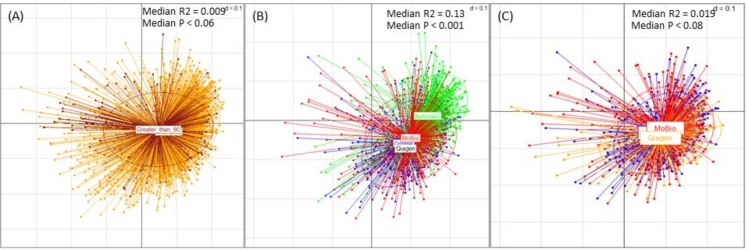
Effect of median read length and DNA extraction techniques on the microbiome variation.(A) PCoA Plot showing the relatedness of the microbiome profiles of the ExperimentHub datasets of different median read length ranges. The different read length categories (into which the datasets were grouped) were’ 30 to 90’ (base pairs) and ‘Greater than 90’ (base pairs). The R-squared value and P-value of the association obtained using bootstrapped envfit iterations (sub-sample size = 200 and number of iterations: 25) are indicated. (B) PCoA analysis of the effects of the DNA extraction methods on the microbiome profiles, indicating that the samples extracted using the method tagged as ‘Illuminakit’ (shown in Green) (used by SchirmerC_201635), had a profile significantly different from those used by other methods (‘Gnome’, ‘Mobio’ and ‘Qiagen’) (bootstrapped envfit median R-squared: 0.13 and median p-value<0.001). Removing these samples in (C) indicated that the rest of the samples had only a marginal effect on the profiles (p<0.08; R-squared = 0.019).